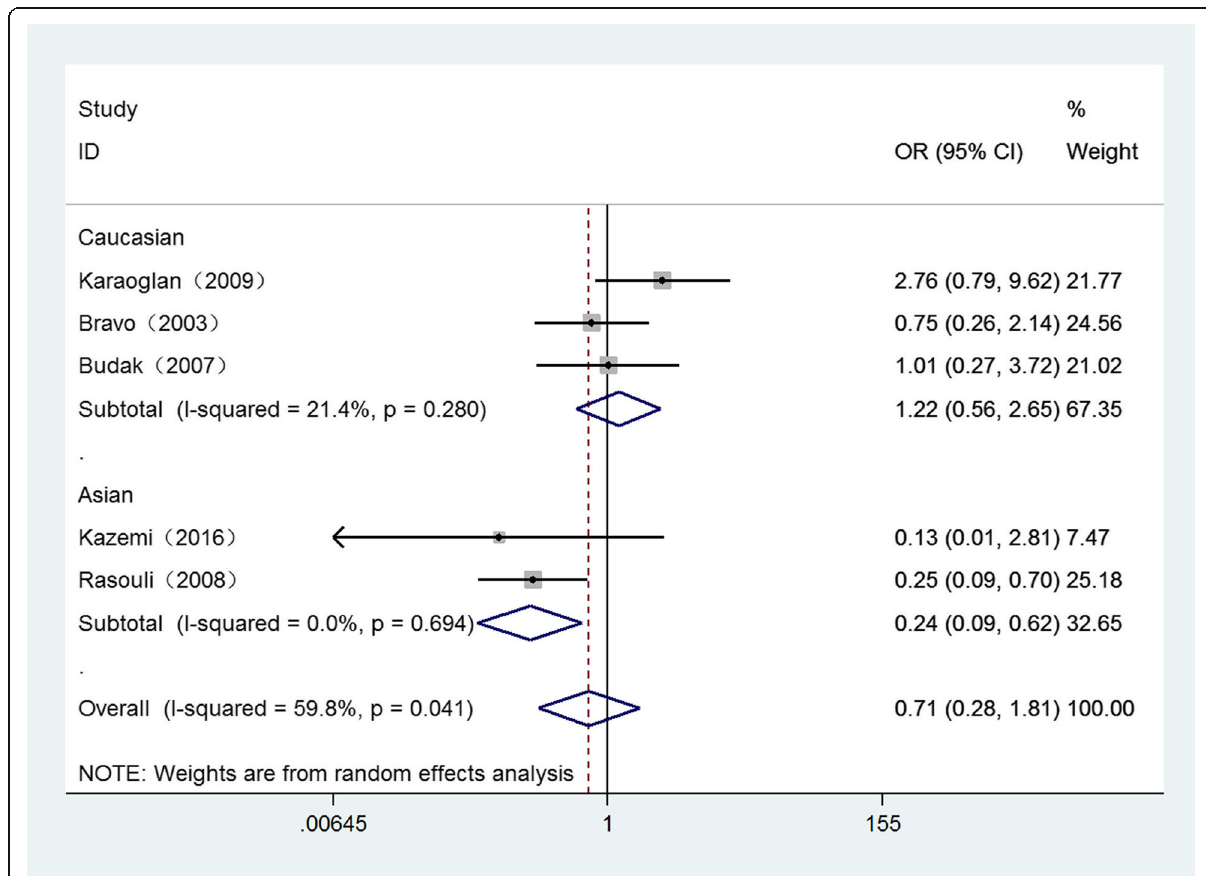
Fig. 3 Forest plot of IL-10 -819 C/T polymorphism on Brucellosis risk in homozygote model (TT vs.